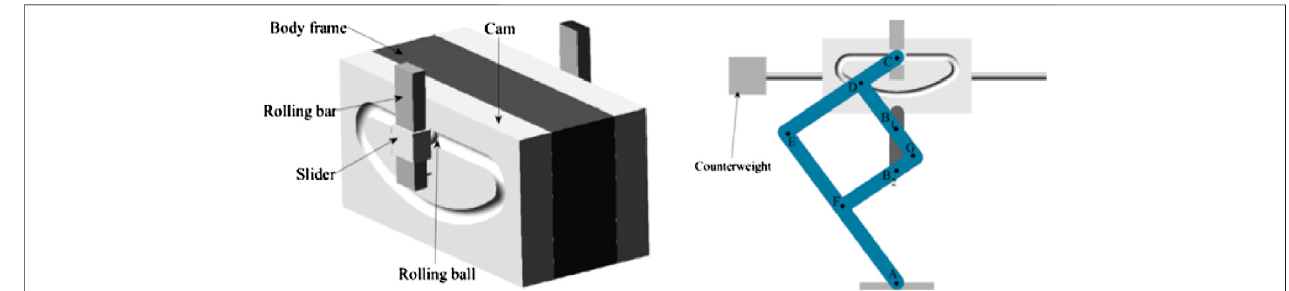
FIGURE 8 | Robot ’ s body and the robot with pantograph mechanism and a